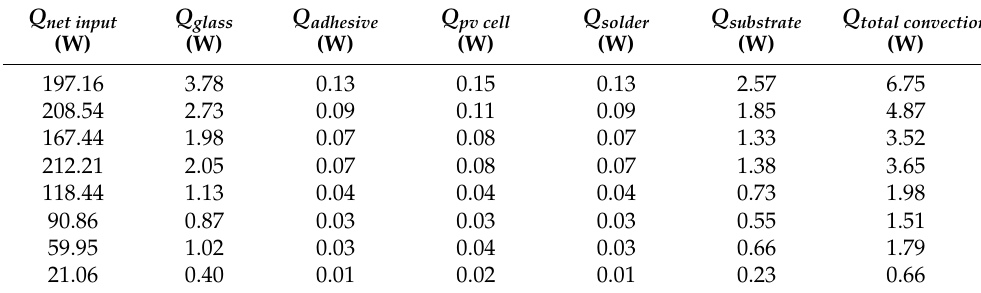
Table 2. Heat transfer through convection from a different cross section of PV cell.